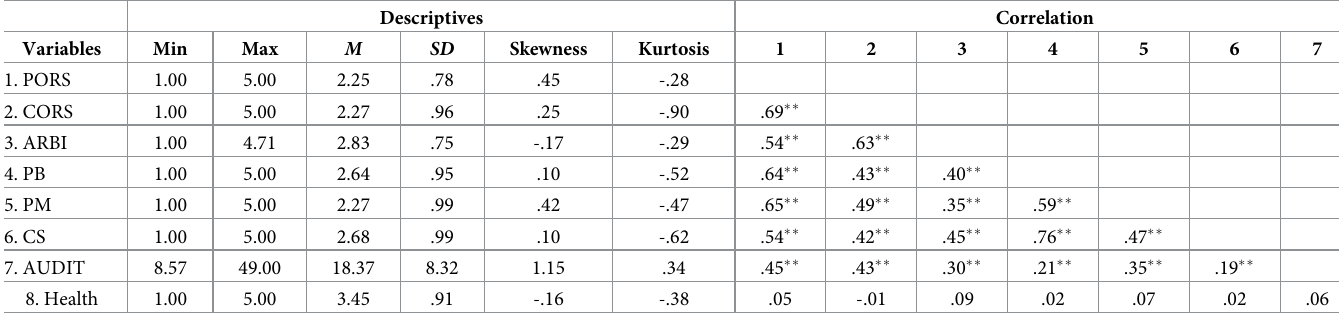
Table 1. Descriptive statistics and bivariate correlations of study